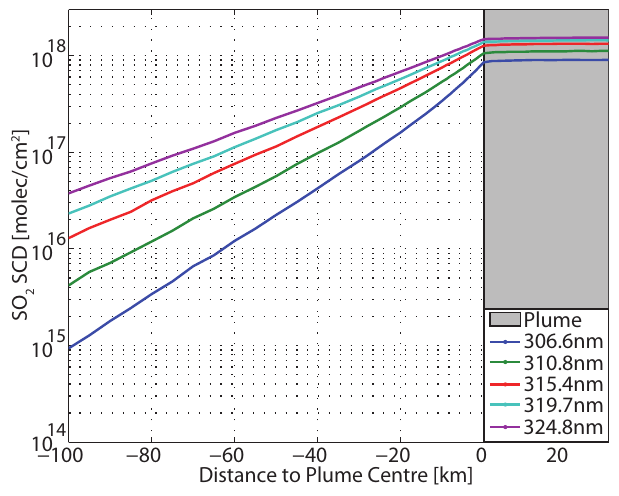
Fig. 13. Simulated SO 2 SCD from model scenario B1. Here, a vol- canic cloud with infinite extent in propagation direction and from the edge onwards was assumed to be at 10km altitude. An SO 2 concentration of 1 × 10 12 moleccm − 3 is assumed for the simula- tion, and the cloud exhibited an aerosol optical depth of 0.1km − 1